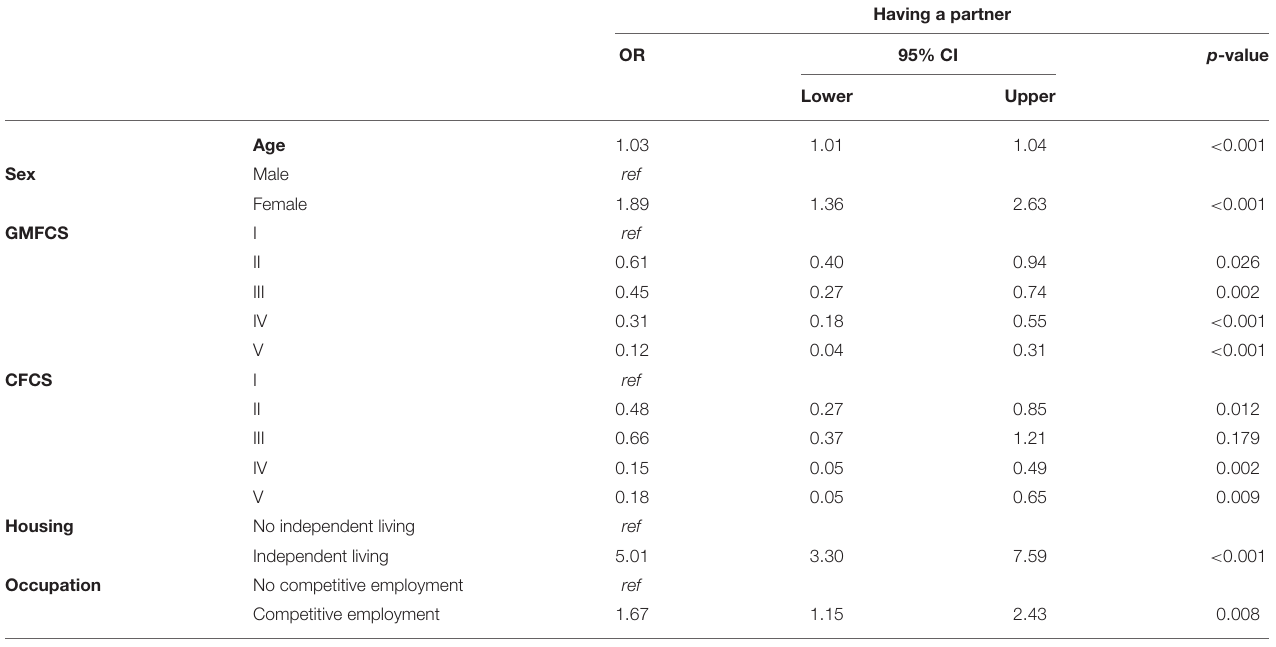
TABLE 3 | Binary logistic regression analyses for having a partner presented as odds ratios (ORs) with 95% confidence intervals